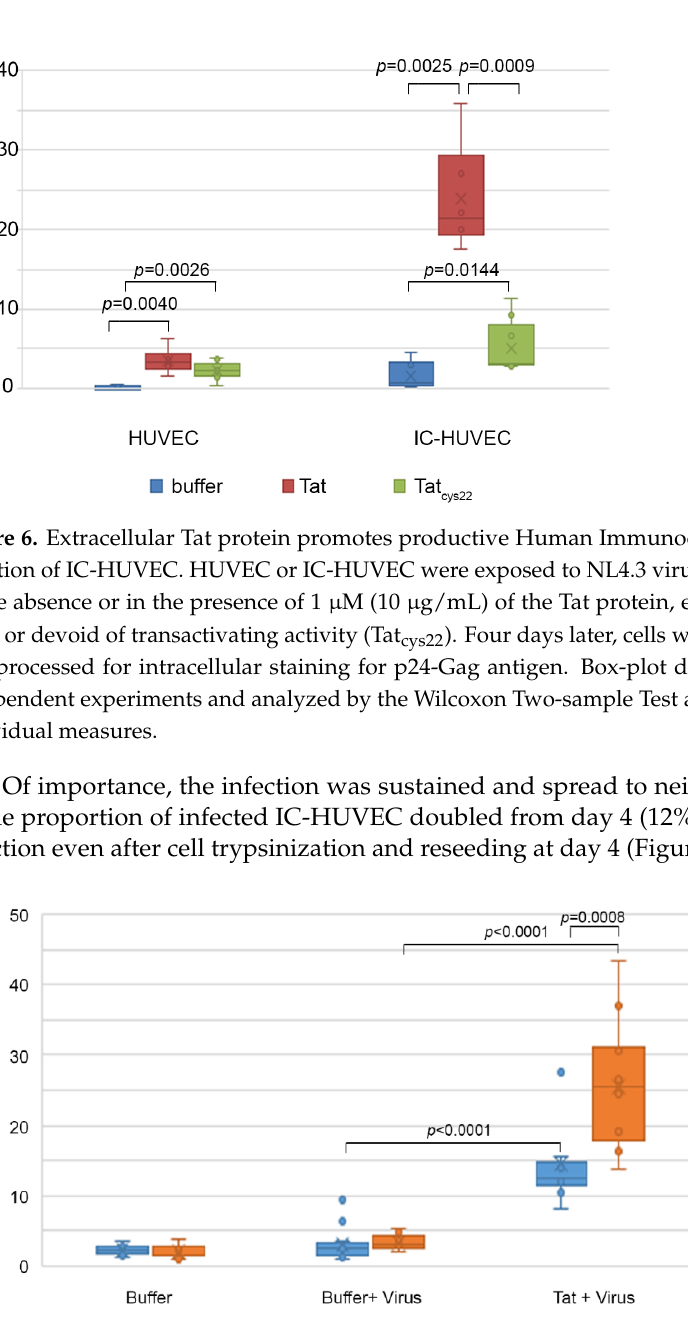
Figure 7. Extracellular Tat protein promotes productive HIV-1 infection of IC-HUVEC. IC-HUVEC were exposed to NL4.3 virus (p24-Gag = 70 ng/mL) in the absence or in the presence of 10 μg/mL of biologically active Tat protein (Tat). Four and 8 days later, cells were washed, trypsinized, and processed for intracellular staining for p24-Gag antigen. Box–plot of data obtained from five inde- pendent experiments and analyzed by the Wilcoxon Two-sample Test are shown. Dots indicate individual measures.